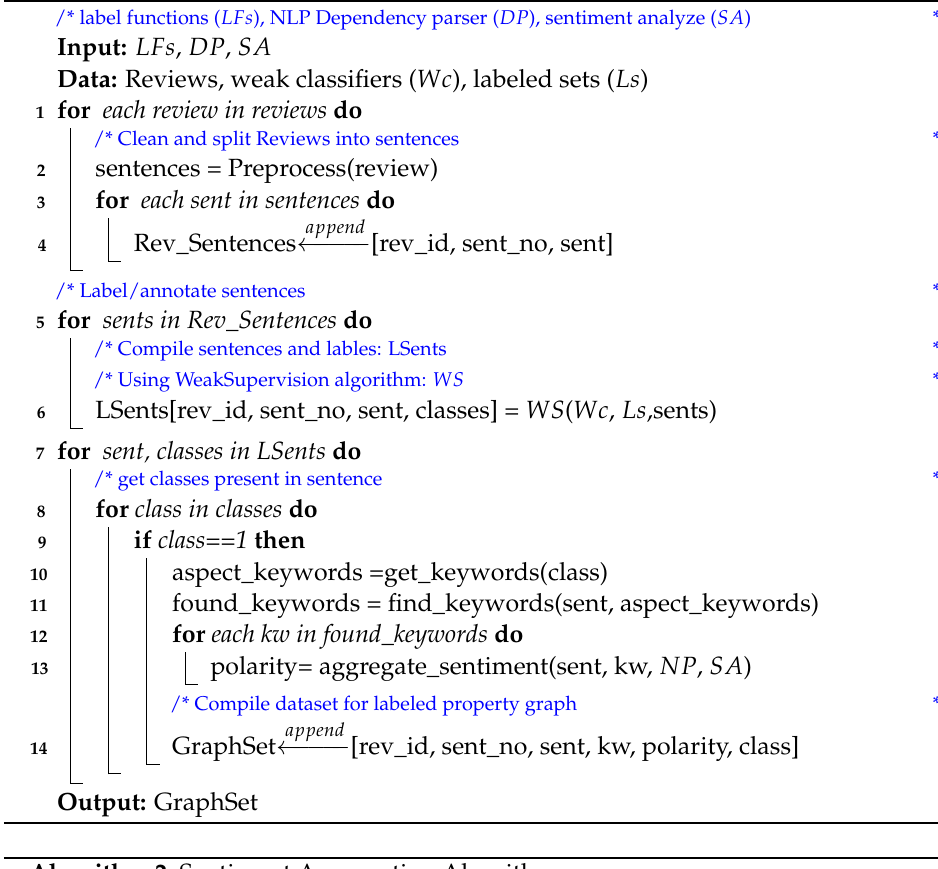
Algorithm 1: Algorithm for generating a dataset for a labeled Property Graph- based customer reviews analysis model.